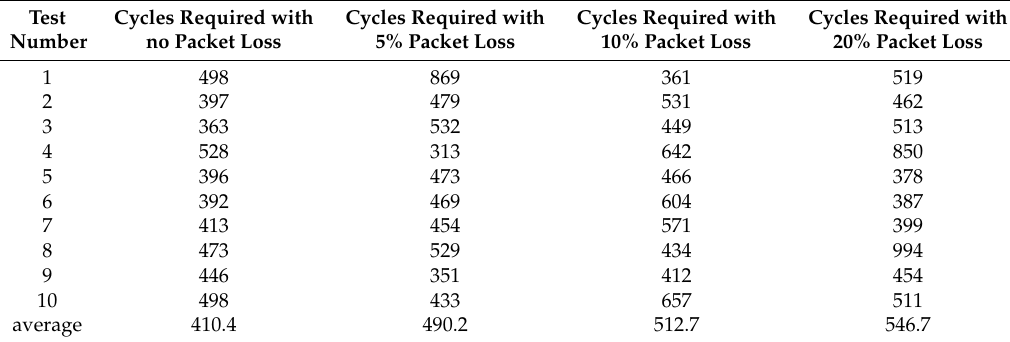
Table 6. Number of cycles required for multi-agent hybrid social cognitive optimization (MAHSCO) to achieve the same accuracy under different packet loss conditions.